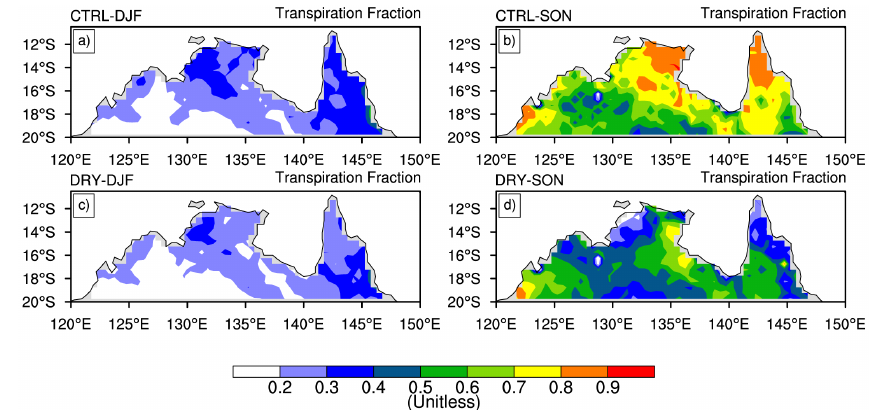
Figure 6. The mean transpiration fraction (fraction of total ET from transpiration defined as the ratio of transpiration over total ET) from the wet season (DJF shown in the left hand column) and the transition between the dry and wet seasons (SON shown in the right hand column). The ensemble mean transpiration fraction to total ET from (a) CTRL over DJF, (b) CTRL over SON, (c) DRY over DJF, and (d) DRY over SON.